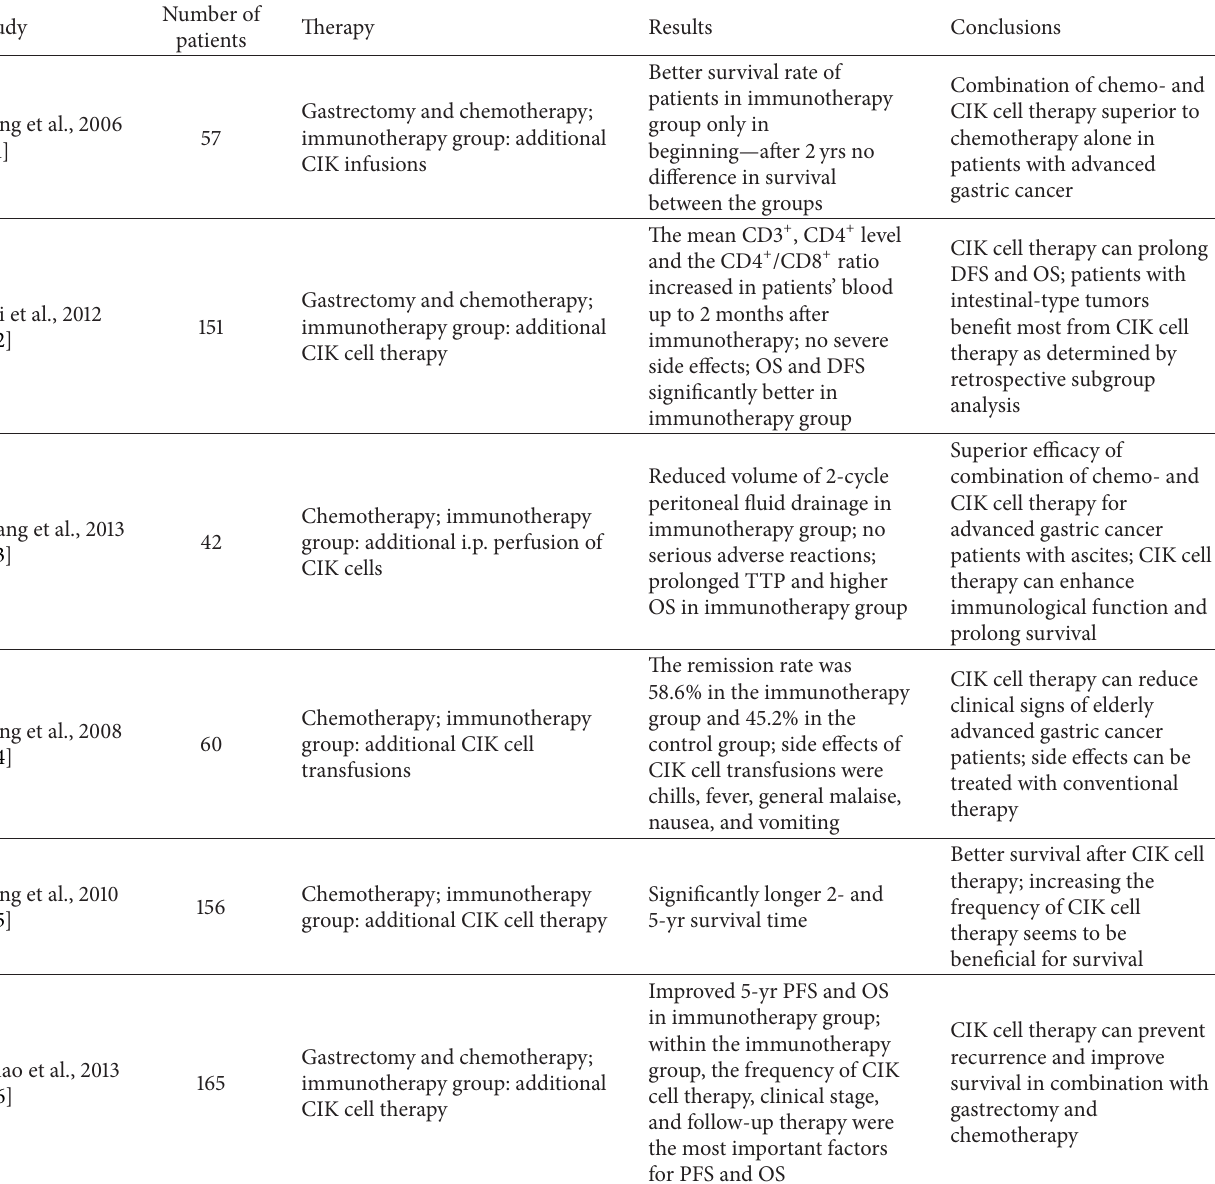
Table 1: Clinical studies applying CIK cells for the treatment of gastric